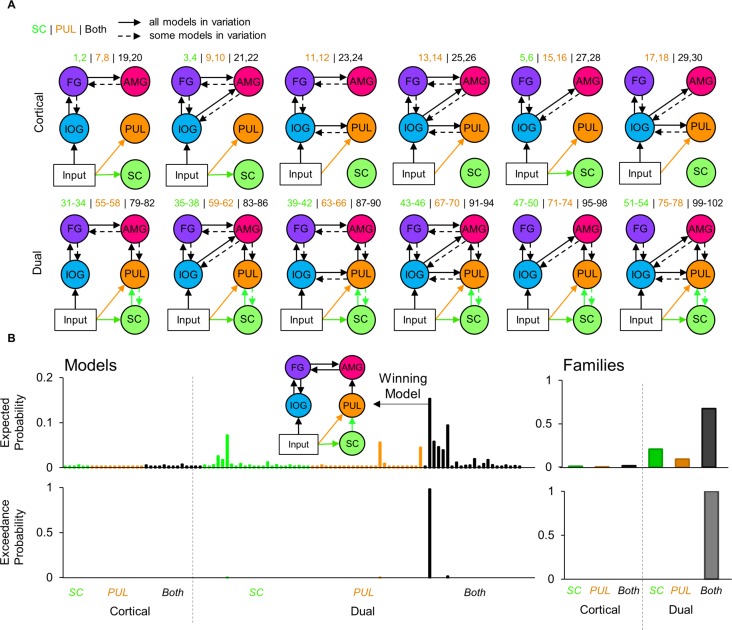
Dynamic causal modelling model space and estimated probabilities.(A) Diagram of the model space constructed for the fMRI activation to viewing faces. The top row shows various types of model designs in the Cortical family, and the bottom row shows model designs in the Dual family (which includes a subcortical route). Each model variation included different combinations of forwards and backwards connections, indicated by dashed arrows. The model numbers are shown above each model variation. Every model contained input to the inferior occipital gyrus but some models also contained input to the superior colliculus (green) only, pulvinar (orange) only, or both (black). (B) The expected (top row) probabilities and exceedance probabilities (bottom row) for each of the 102 models. The colour of the bars indicates the different type of input for that family (i.e., SC, PUL, or both), according to A). Individual model probabilities are shown on the left (including a diagram of the winning model) and the probabilities for the families are shown on the right.